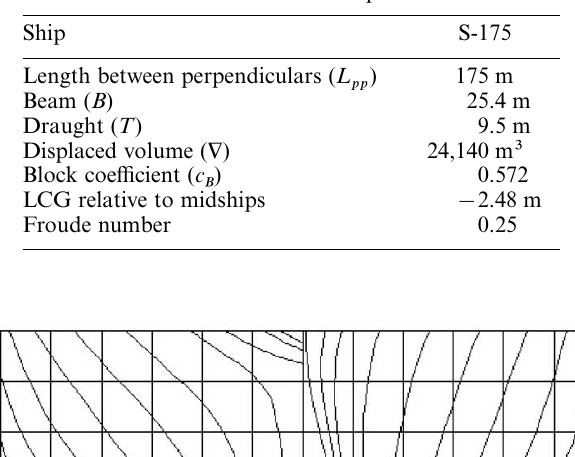
Table 1. The S-175 main particulars.